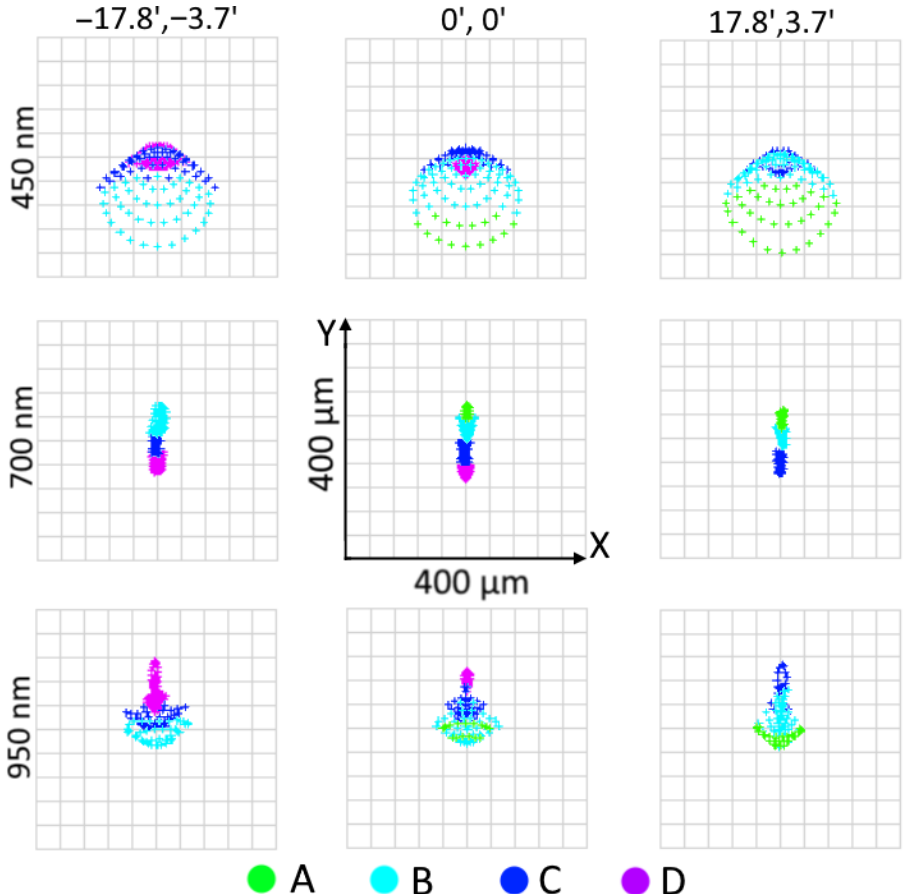
Figure 5. Spot diagrams of the spectrograph with composite